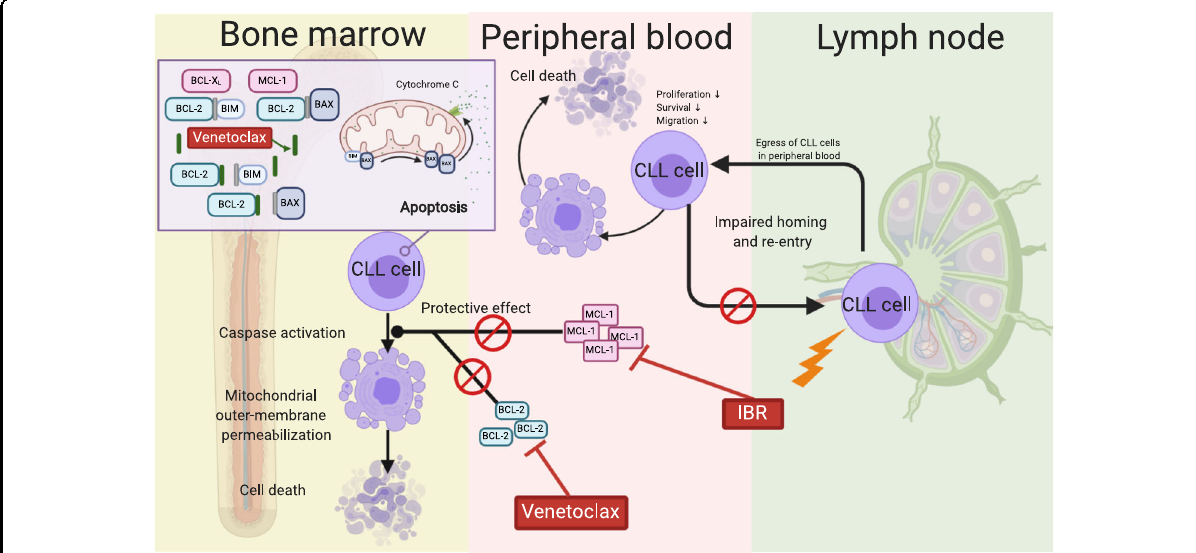
Fig. 4 Rationale for ibrutinib combination with targeted agent venetoclax. Ibrutinib (IBR) results in mobilization of CLL cells from protective microenvironment niches in lymph nodes, while venetoclax hits CLL cells residing in the blood and bone marrow. Venetoclax targets BCL-2 to induce apoptosis, but MCL-1 could protect malignant cells from mitochondria-mediated cell death. IBR treatment results in a decrease in MCL-1 protein level and leads to synergy when combined with venetoclax. This fi gure was created with